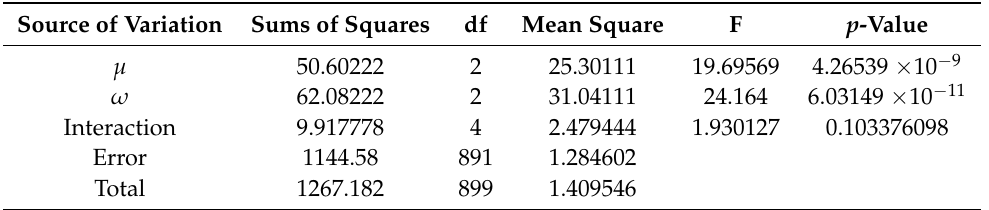
Table 1. The variance analysis of the two parameters on the loop cutset size.